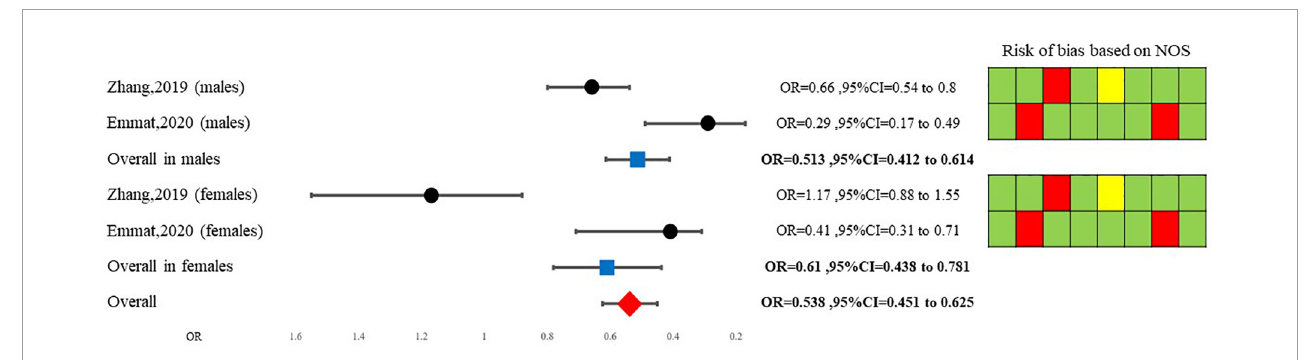
FIGURE3 Findings of quantitative synthesis pooling